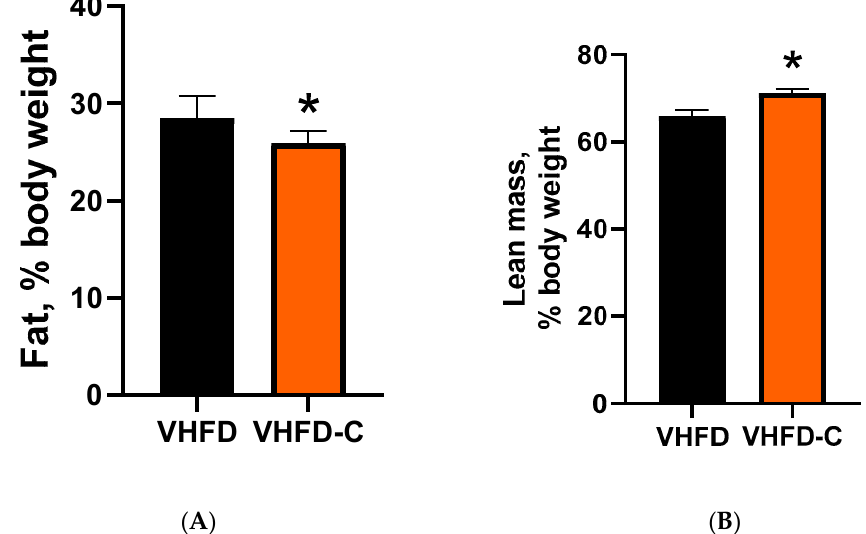
Figure 3. Effect of curcumin on mouse fat and lean body weight. Total body adiposity evaluation was conducted on week 12 of feeding the animals with designated diets on the Whole Body Composition Analyzer (EchoMRI). * indicates a significant difference at p value ≤ 0.05. ( A ) Fat body mass. P value 0.041. ( B ) Lean body mass. p value 0.005. Data represented as mean with standard error of the mean; n = 10.